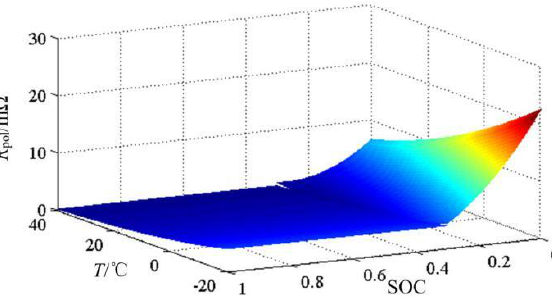
Table 3. Measurement of τ at typical temperature. Temperature (°C)